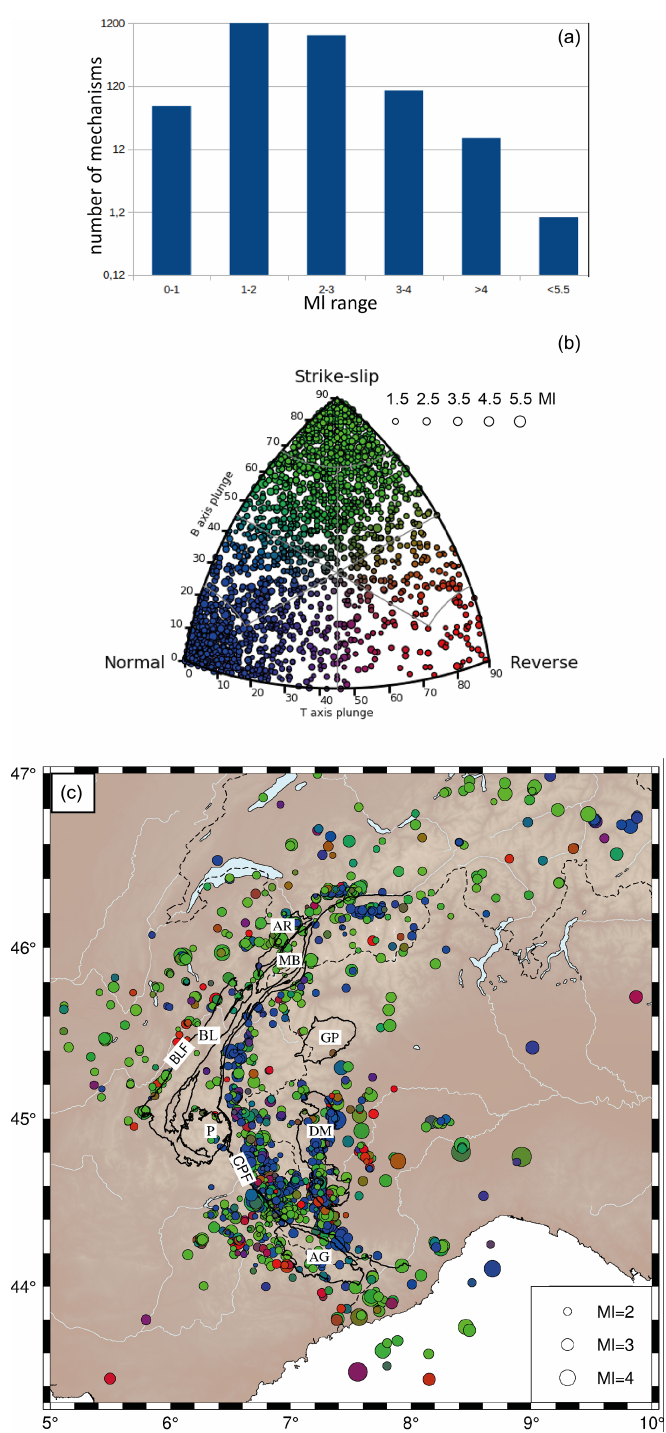
Figure 2. Set of the 2215 focal mechanisms computed in this study. (a) Histogram of magnitude distribution (local magnitude, M l ) for the computed focal mechanisms. (b) Kaverina diagram displaying the style of deformation of the mechanisms according to their T axis (tension axis) and B axis (null axis) plunges. Normal, reverse, and strike-slip deformation style corresponding to the vertical P , T , and B axes is indicated by circles in blue, red, and green, respectively. (c) Localization of the focal mechanisms colour-coded according to their classification in the Kaverina diagram in (b) . Note the different scale for events size between (b) and (c) . Black lines outline the crystalline massifs of the area. External crystalline massifs (Aiguilles Rouges, AR; Mont Blanc, MB; Belledonne, BL; Pelvoux, P; Argentera, AG) are separated from the internal crystalline massifs (Gran Paradiso, GP; Dora Maira, DM) by the Crustal Penninic Front (CPF). The Belledonne external massif is delineated by the Belledonne Fault (BLF) along its western